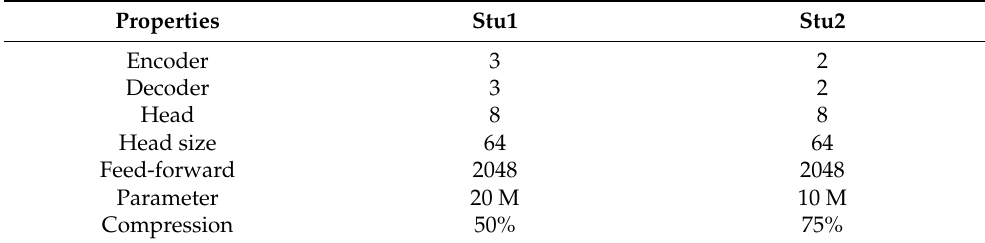
Table 1. The settings of two student models.